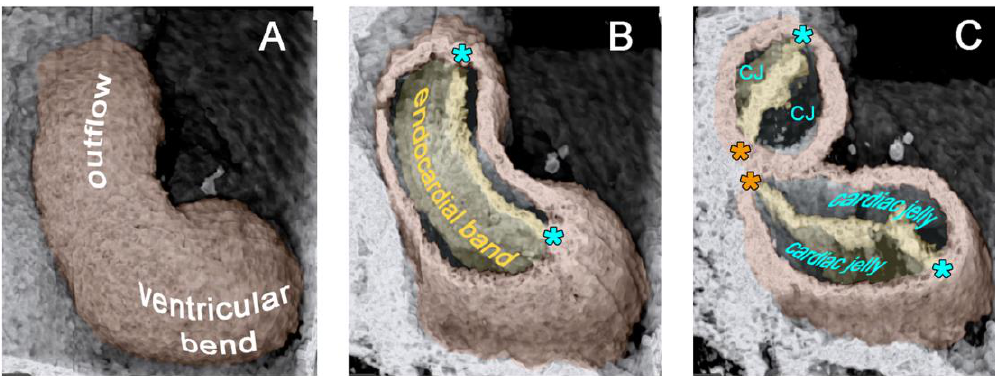
Figure 6. These 3D-images, acquired in vivo by 4D optical coherence tomography (OCT) [73], show various aspects of the wall architecture of the primary ventricular tube of a HH-stage 12/13 chick embryo heart as seen in right lateral views. Pictures show the ventricular bend and outflow in a fully contracted (end-systolic) state. ( A ) Outer shape of the myocardial tube. ( B ) 3-D shape of the occluded endocardial tube as shown by virtual removal of parts of the myocardial wall. Note that the collapsed endocardial tube has the shape of a flat band, whose edges are fixed to the original ventral and dorsal midlines of the heart tube (marked by blue and orange asterisks, respectively). ( C ) Cross-sections of the ventricular tube at the level of the ventricular bend and outflow as depicted by virtual dissection of OCT datasets. Note that the flattened endocardial tube is flanked by paired accumulations of CJ, which have half-moon shaped cross-sections. The paired character of the CJ-layer reflects the origin of the ventricular tube from the bilaterally paired heart fields.